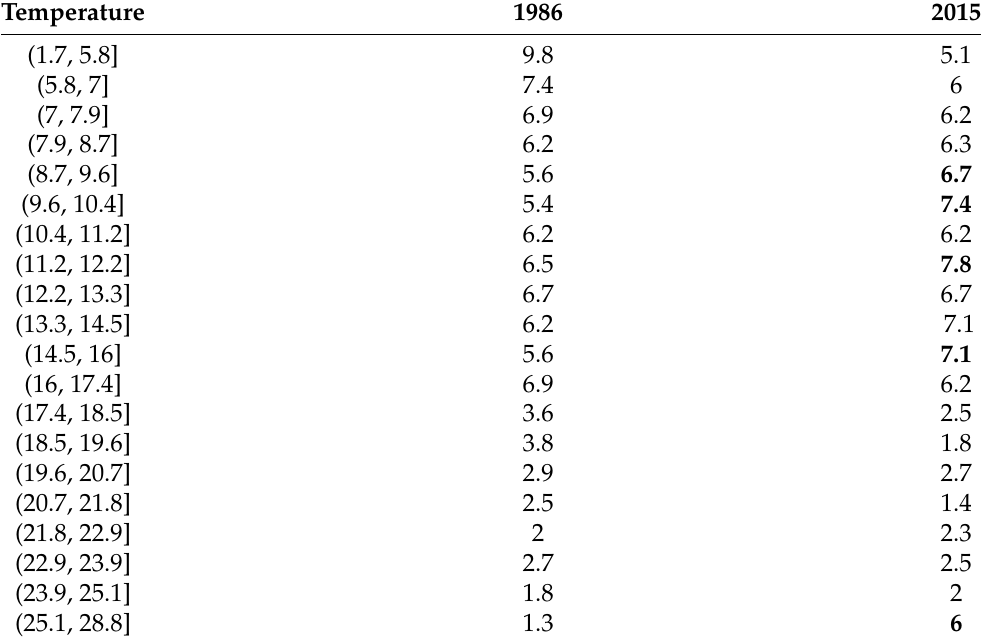
Table 4. Percentage of meteorological stations in temperature classes for Campania in 1986 and 2015. Those percentages of meteorological stations higher than 1% in 2015 with respect to 1986 are in